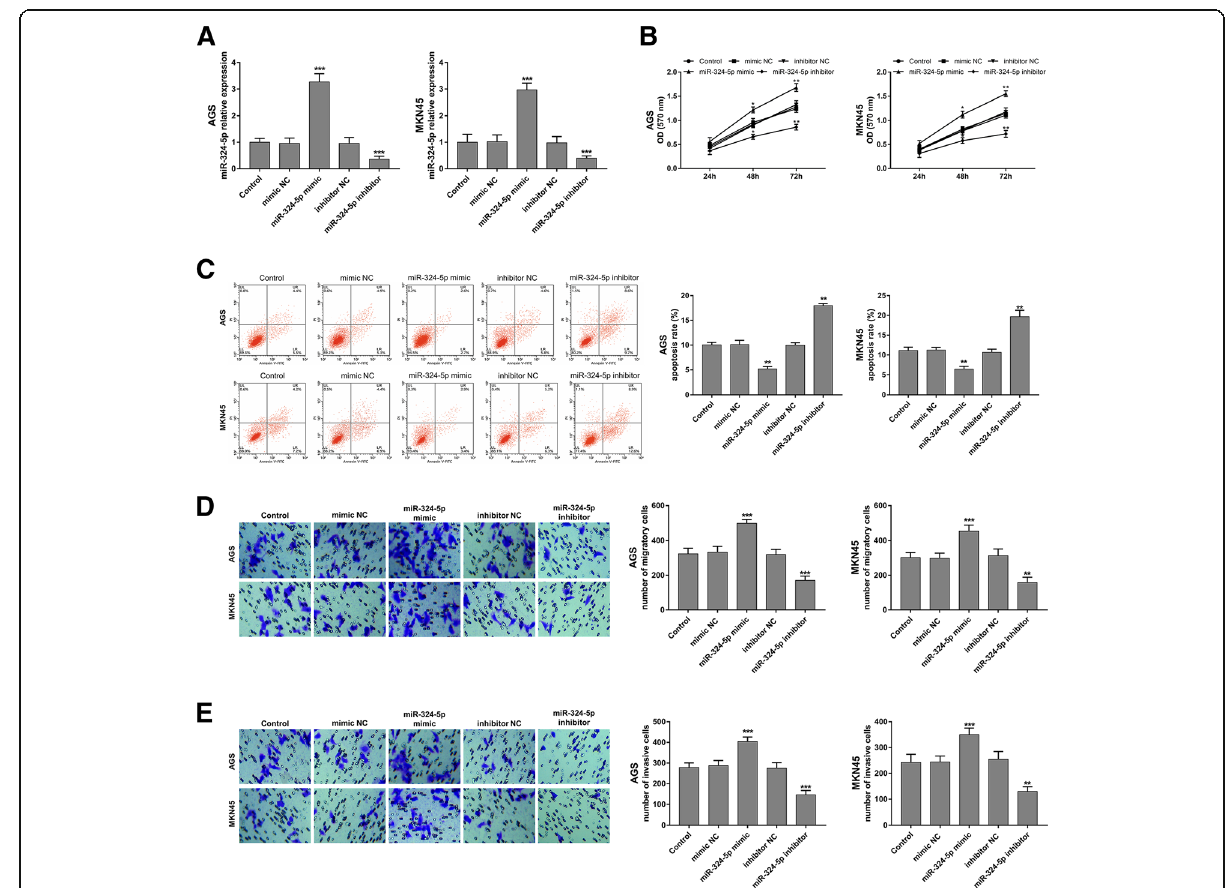
Fig. 3 Effect of miR-324-5p on cell proliferation, apoptosis, migration and invasion in AGS and MKN45 cell lines. a . miR-324-5p expression was upregulated by the miR-324-5p mimic and downregulated by the miR-324-5p inhibitor in GCa cells. b . The overexpression of miR-324-5p enhanced cell proliferation, but the silencing of miR-324-5p inhibited cell proliferation in both the AGS and MKN45 cell lines. c . miR-324-5p overexpression led to reduced cell apoptosis, but miR-324-5p reduction resulted in increased cell apoptosis in both AGS and MKN45 cell lines. d . The migration ability of both two GCa cell lines was promoted by the overexpression of miR-324-5p, but was suppressed by the knockdown of miR-324-5p. e . The invasion of AGS and MKN45 cells was accelerated by the upregulation of miR-324-5p while inhibited by the downregulation of miR-324-5p. * P < 0.05, ** P < 0.01, *** P <